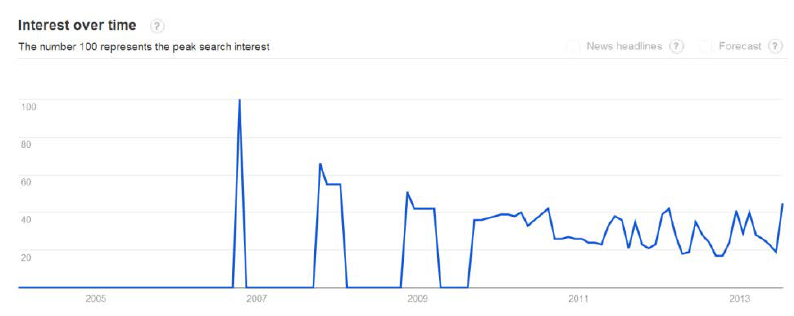
Figure 1. Search frequency of “online learning security” shown by Google